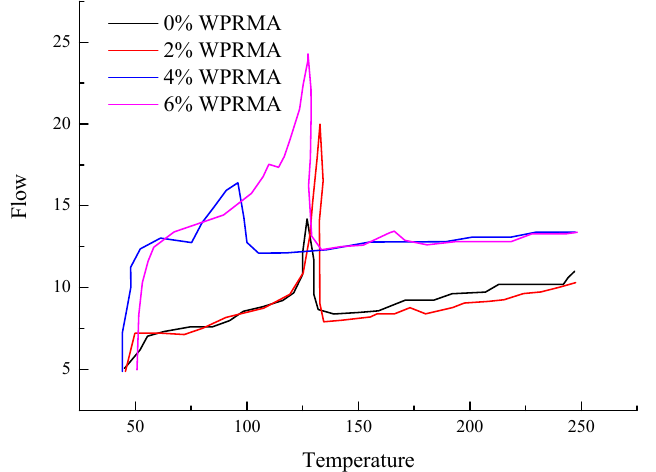
Figure 10. Differential scanning calorimeter curves of waste plastic/rubber-modified asphalt.